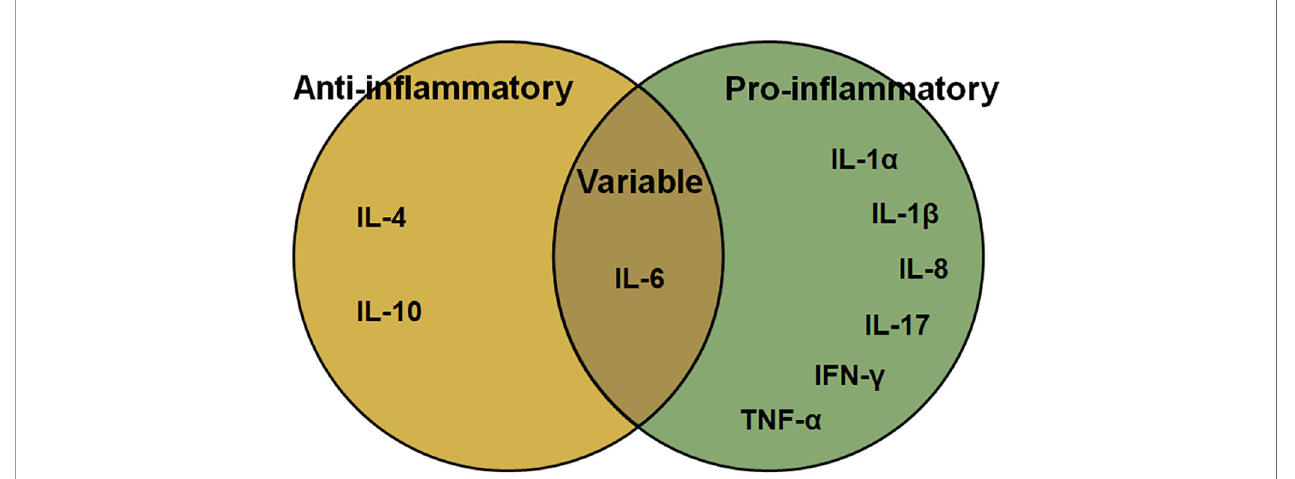
FIGURE 1 | The function of cytokines in Chlamydia -induced in fl